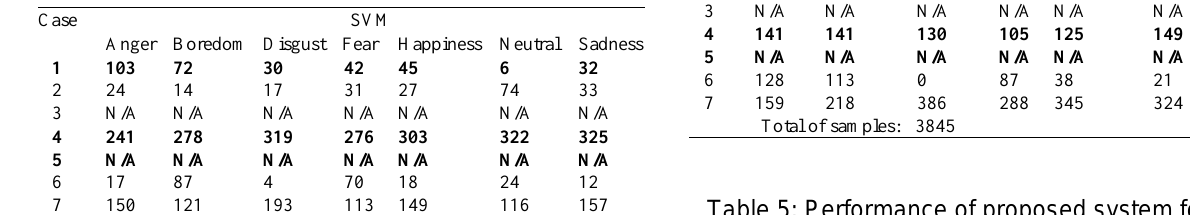
Table 5: Performance of proposed system for online